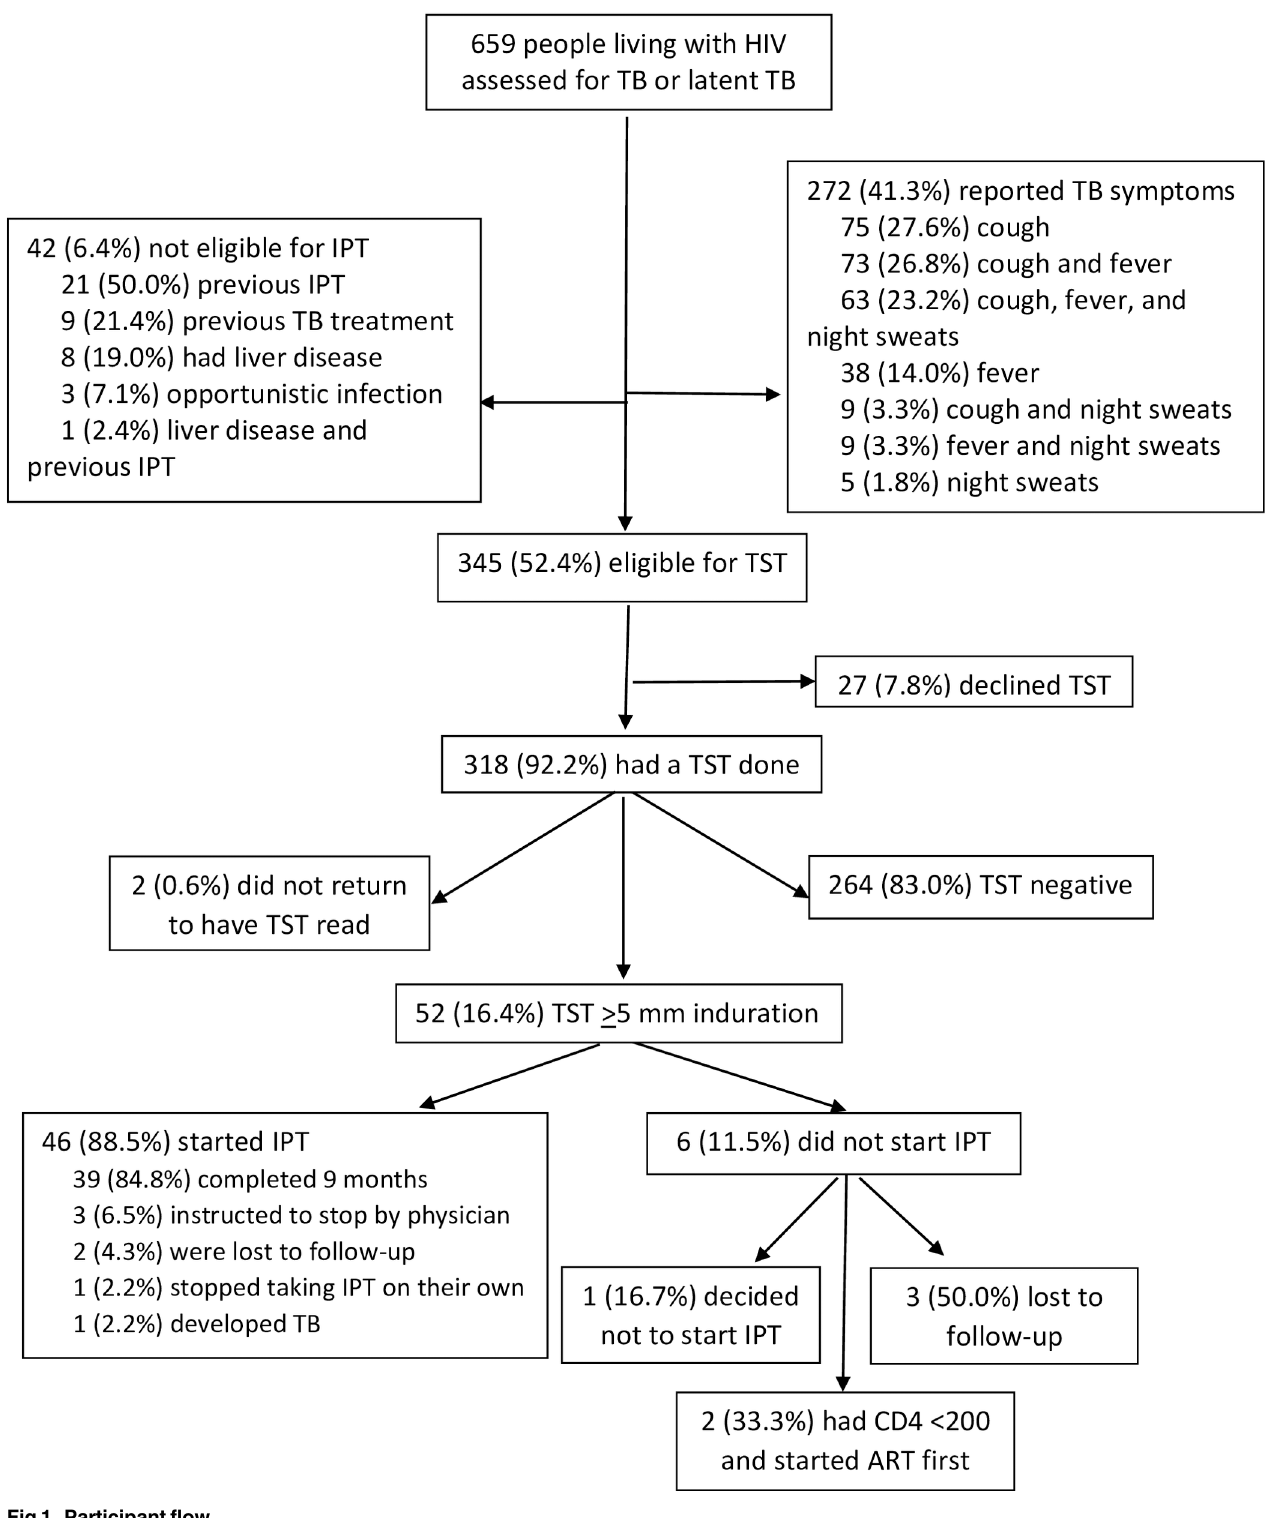
Fig 1. Participant flow.